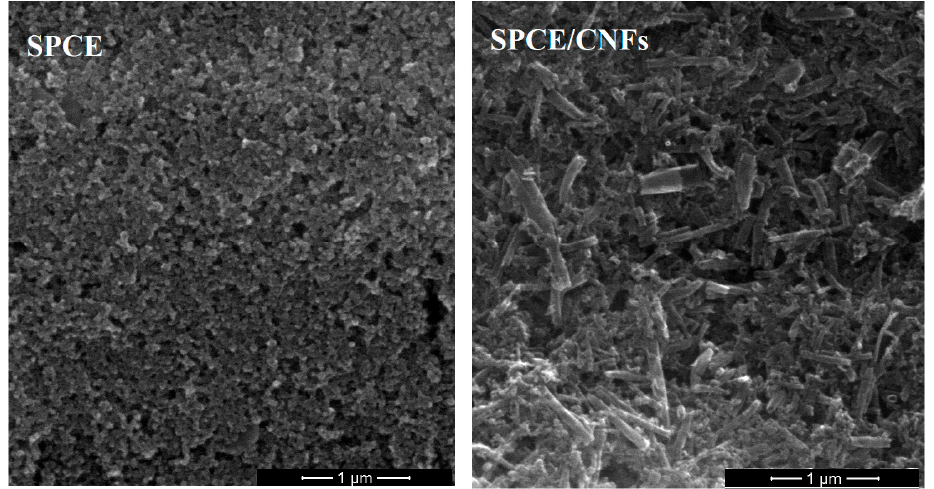
Figure 3. SEM images of SPCE and SPCE/CNFs.